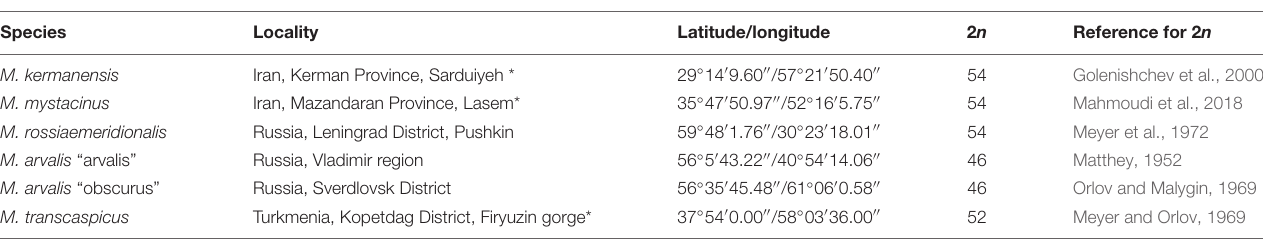
TABLE 1 | List of the taxonomic groups examined.